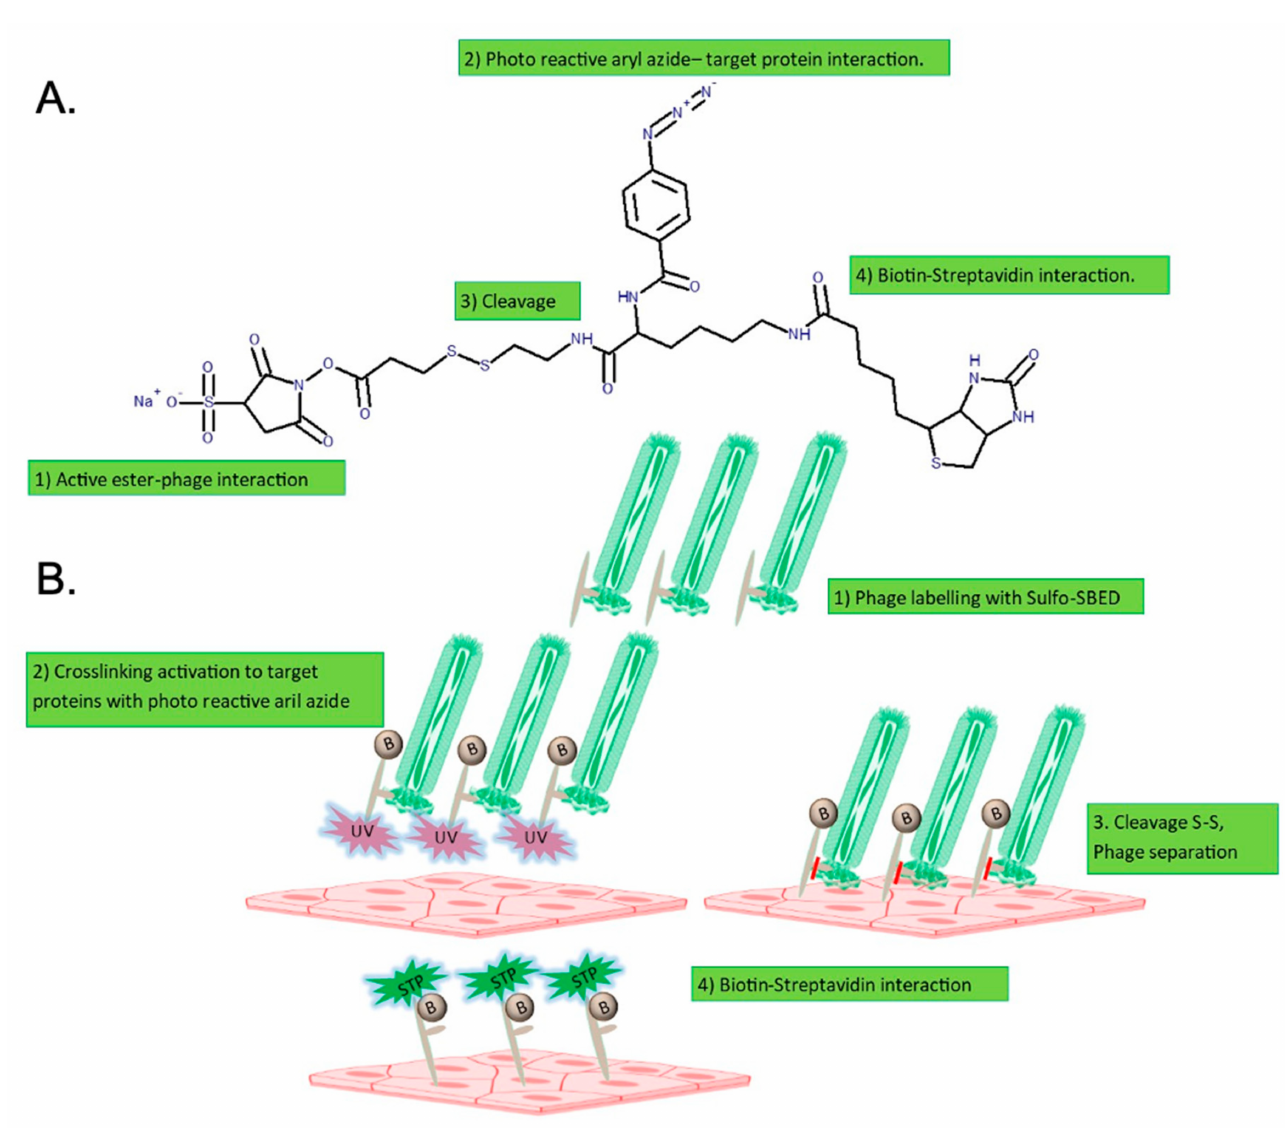
Figure 6. Experimental strategy for detection and isolation of target proteins of peptide-88. ( A ) Molecular structure of sulfo-SBED. ( B ) Crosslinking phage peptide ligand with hCMEC/D3 targets. Biotin (B), streptavidin (STP), ultraviolet